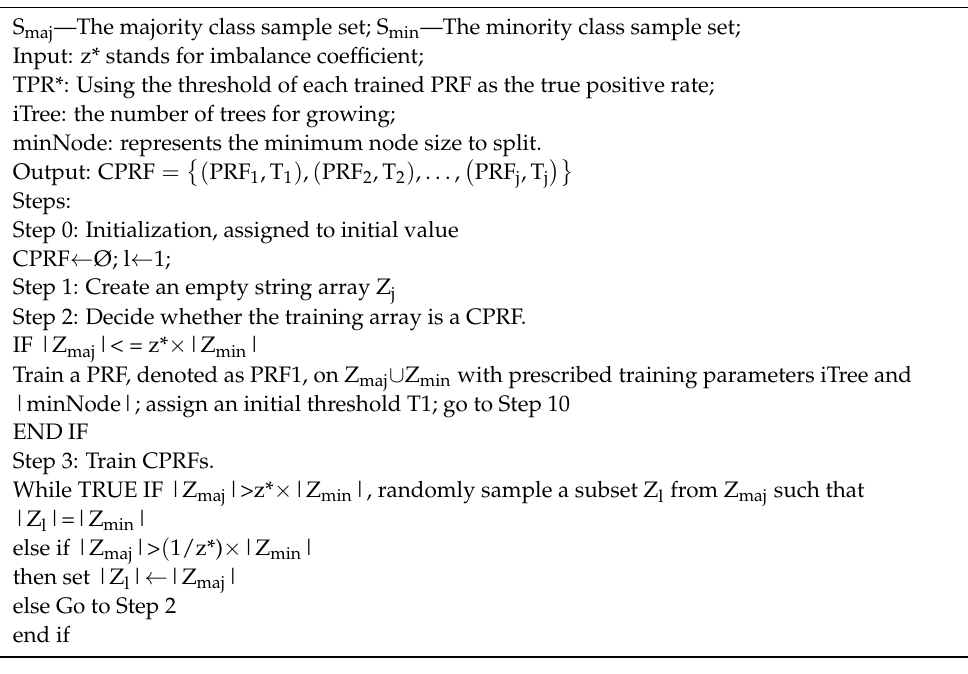
Algorithm 1: Balanced dimension reduction in the cascading